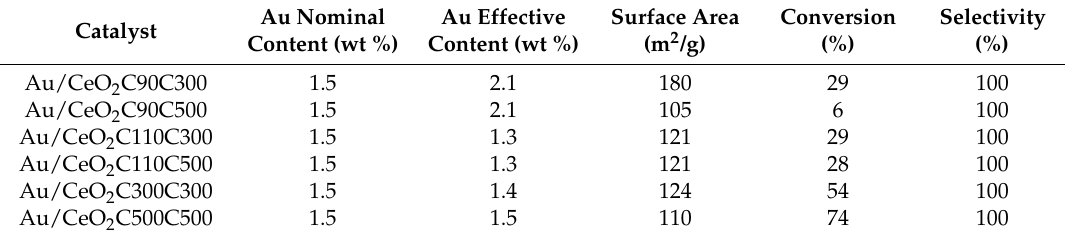
Table 6. Properties of the samples and catalytic activity after 90 min reaction.